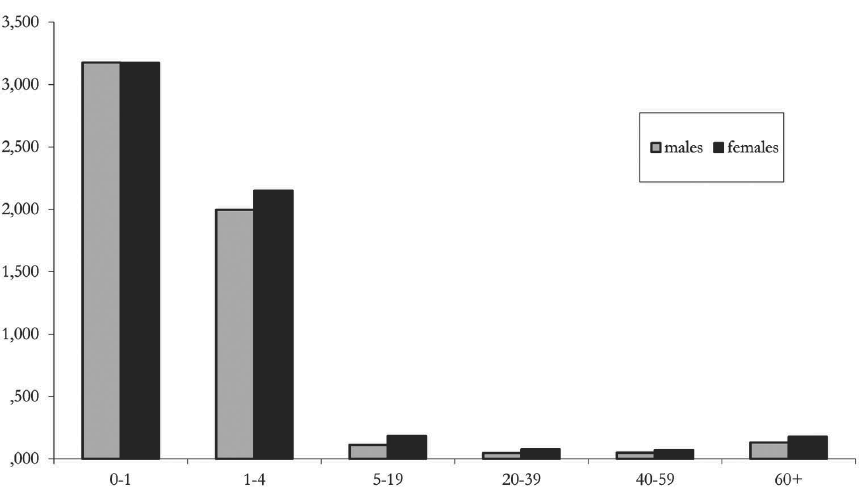
Figure 9 – Age and sex specific death rates for abdominal tuberculosis in Italy